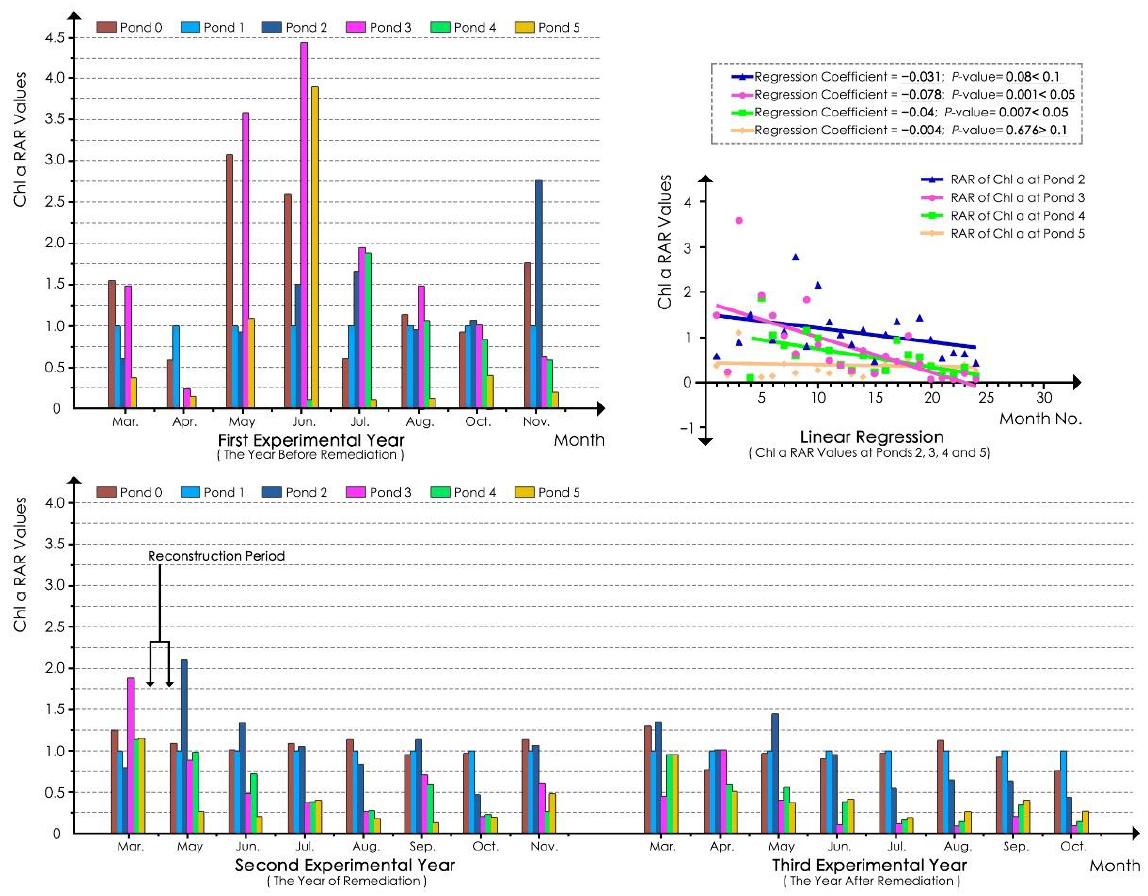
Figure 4. Chl a RAR values for each pond. According to linear regression analyses of the water transparency values of samples at each pond for the whole experimental process (Figure 3), the regression coefficients of the pond 2, 3, and 4 models were 0.887, 1.569, and 2.296, respectively, and the p -values were all less than 0.05. These results indicated that the water transparency of ponds 2, 3, and 4 was significantly improved. In addition, the improvement effects in ponds 3 and 4 were much better than that in pond 2, and that in pond 4 was better than that in pond 3. In contrast, the regression coefficient of the pond 1 model was 0.112, and its p -value was 0.794, indicating that its water transparency did not significantly increase or decrease during the experimental period. According to the bar chart in Figure 3, the water transparency of the reference pond (pond 1) remained low throughout the entire experimental process. The values were slightly higher in the spring of the second experimental year, whereas they were much lower in the summer and autumn than those in the summer and autumn of the first experimental year. In the third experimental year, the water transparency of pond 1 increased compared with that in the second experimental year, especially in spring, whereas the values in summer and autumn were still lower than those in the first experimental year. These results showed that, without any remediation measures, the water transparency fluctuated from year to year, remaining at a relatively low value, especially in summer and autumn. Before ecological remediation, the water transparency of each remediated pond was lowest in summer and increased gradually in autumn. After ecological remediation, the water transparency of the ponds that were remediated gradually improved in summer. The transparency of ponds 2, 3, and 4 increased by 23 to 68 cm in summer of the third experimental year compared to the transparency in the first experimental year, especially at pond 4, in which the transparency values in July and August increased by 53 cm and 68 cm, respectively. In terms of the